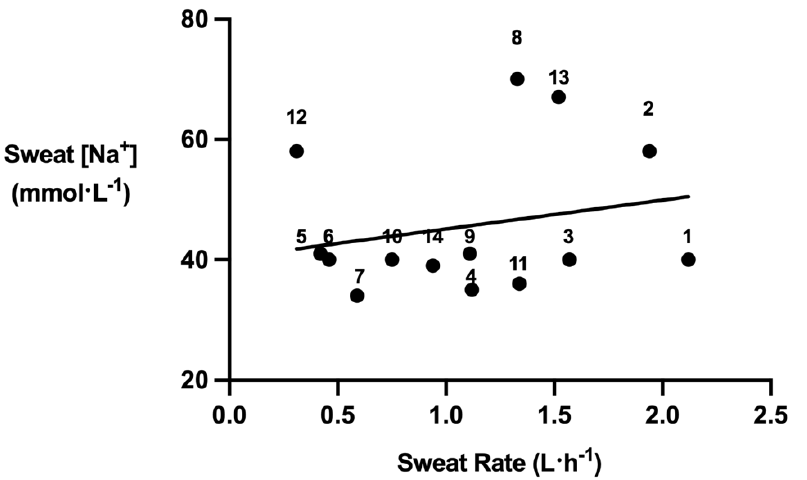
Figure 4. Players’ sweat [Na + ] losses. Number (n) above the symbol denotes player number.